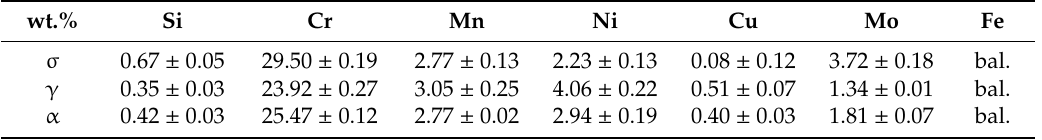
Table 2. Average scanning electron microscope energy-dispersive X-ray spectroscopy (SEM-EDS) semi-quantitative analysis in the bright phase particles detected in samples heat treated at 750 °C for 60 min (Figure 2d). As a comparison, the average α and γ phase compositions in the same sample are also reported.